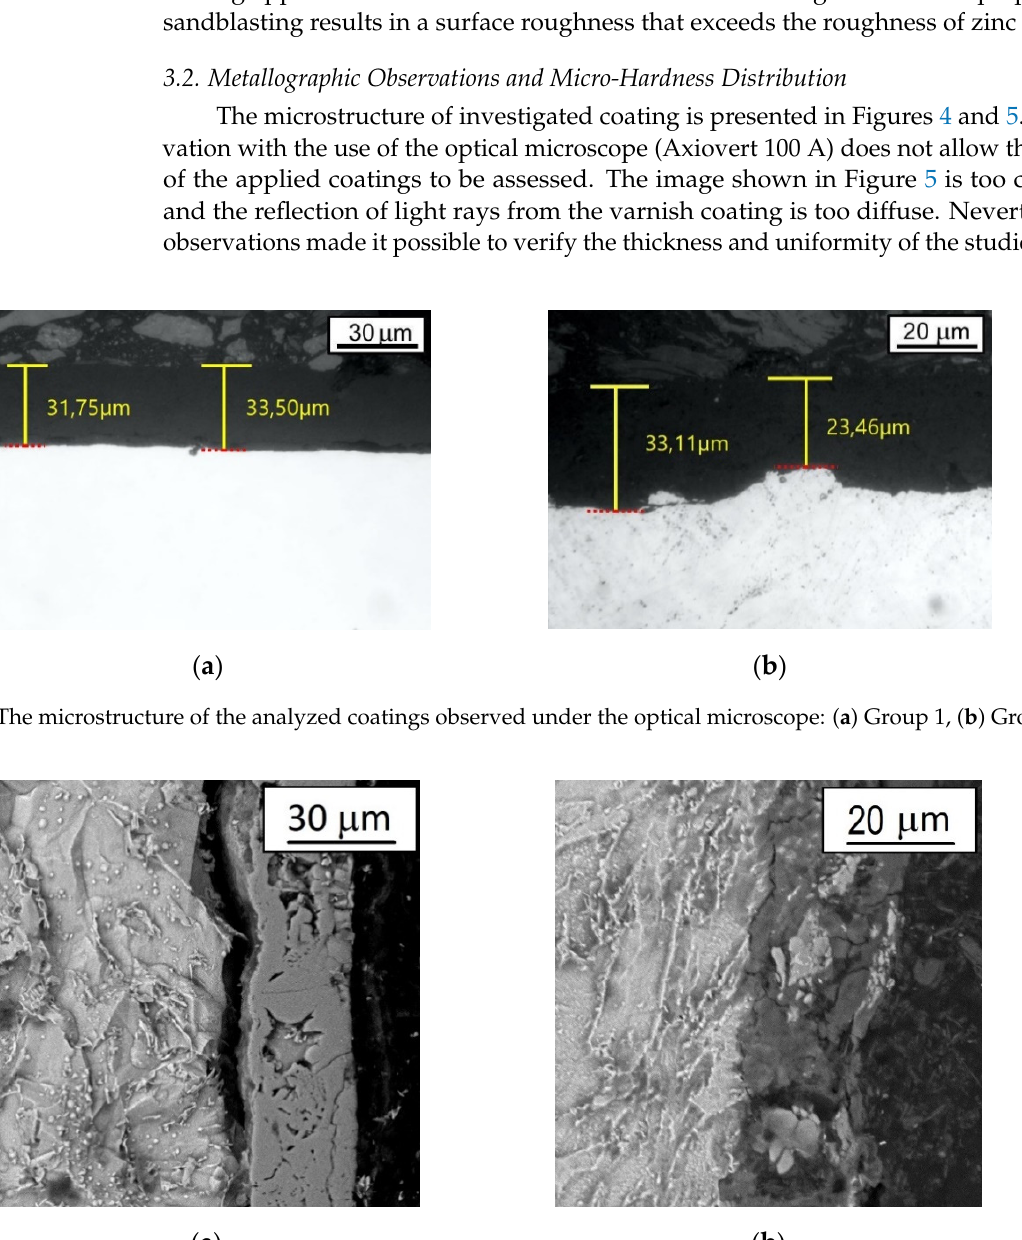
Materials 2021 , 14 , x FOR PEER REVIEW